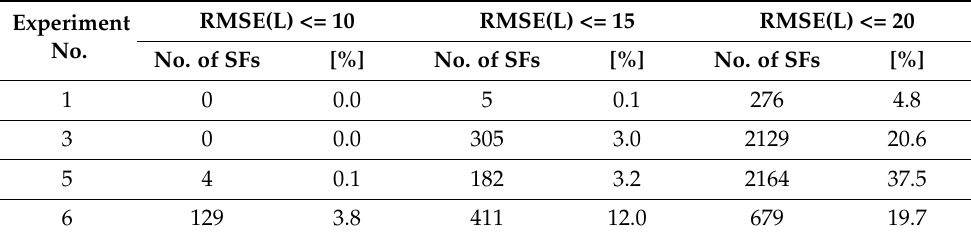
Table 4. Number of SFs that meet criterion RMSE (L) for individual experiment.